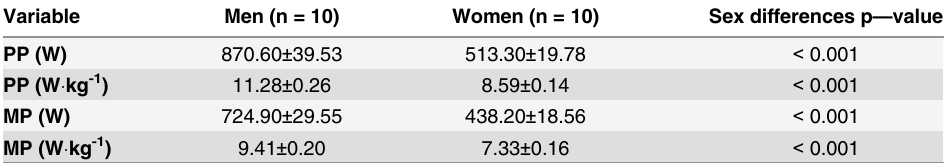
Table 2. Absolute (W) and relative (W (cid:1) kg -1 ) values of peak and mean anaerobic power (PP and MP) achieved during a 20-second anaerobic exercise (AnEx) by men and